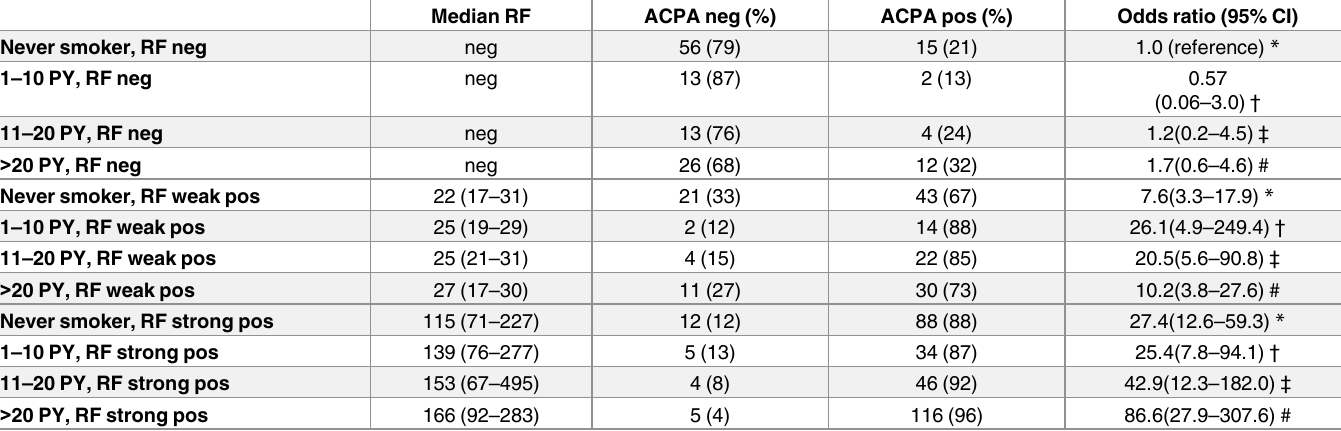
Table 3. Cohort 1 relationship between smoking, RF and ACPA.